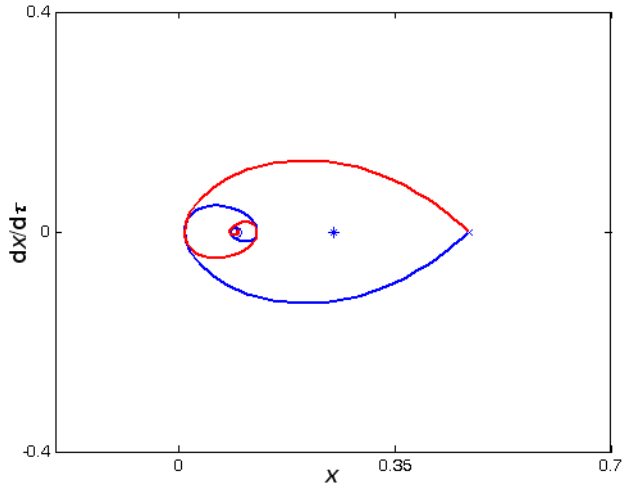
Figure 12. Heteroclinic orbits with 0 a =